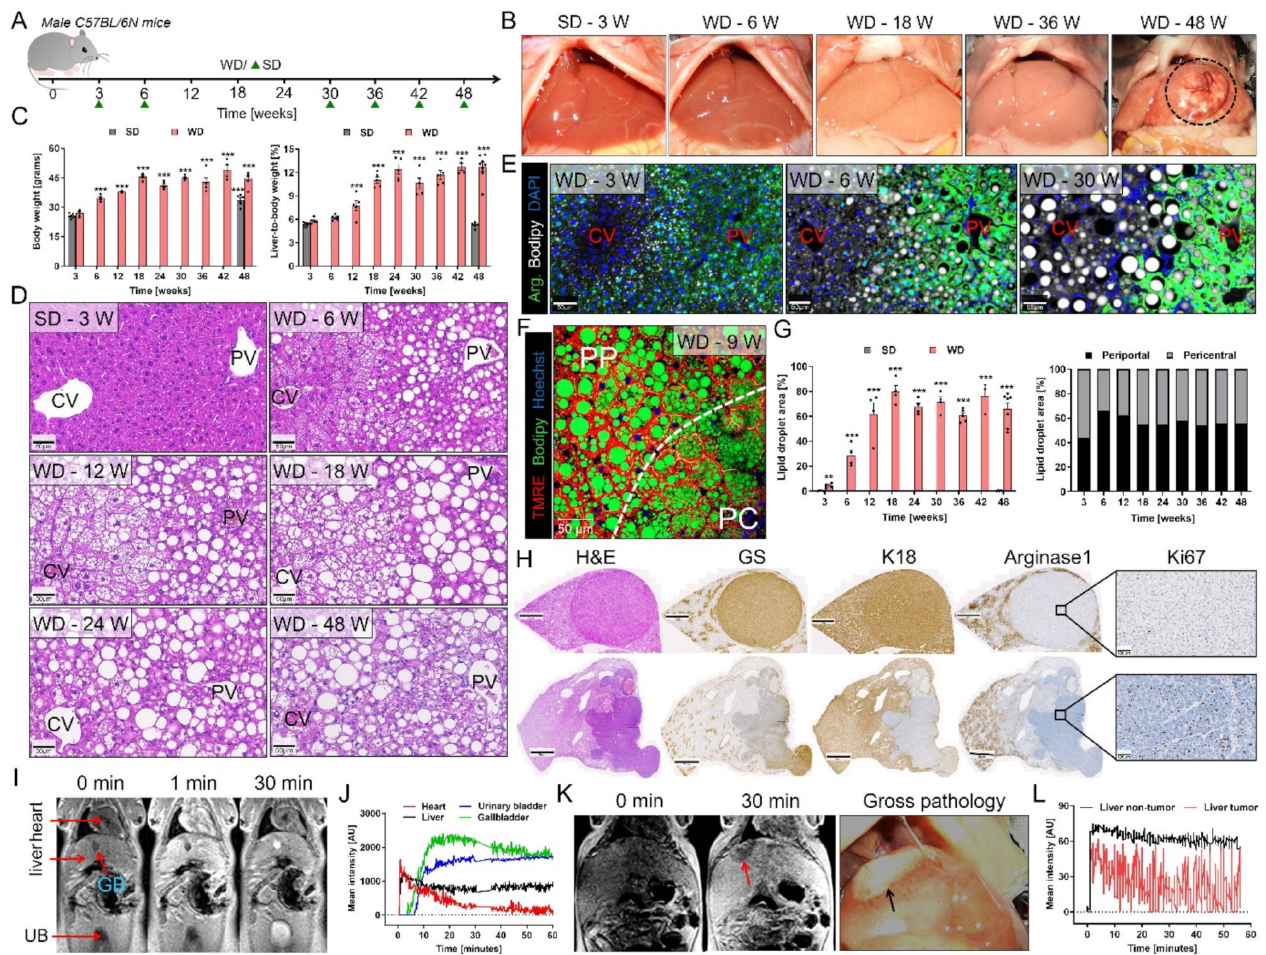
Figure 1. Lipid droplet accumulation and tumor development after Western diet feeding. ( A ) Experimental schedule indicating the number of weeks mice were on a SD or WD prior to analysis; green triangles: time periods with SD controls (details: Table 3). ( B ) Macroscopic appearance of the livers of mice on SD (week 3) and WD over 48 weeks. ( C ) Body weight and liver-to-body weight ratio. ( D ) Lipid droplet (LD) formation in H&E-stained liver tissue sections of mice fed a WD over 48 weeks; scale bars: 50 µ m. ( E ) Zonation of LD formation. LD appear white, the periportal/midzonal regions are green due to immunostaining for arginase1 (Arg.); blue represents nuclear staining by DAPI; CV: central vein; PV: portal vein; scale bars: 50 µ m. ( F ) Intravital visualization of LD using Bodipy (green). Differentiation of the periportal (PP) and pericentral (PC) lobular zones was achieved using the mitochondrial dye, TMRE, that leads to a stronger signal in the PP than the PC zone; scale bar: 50 µ m (see also Videos S1 and S2). ( G ) Quantification of LD in relation to lobular zonation. Data in C and G represent the mean and standard error of 4–7 mice per time point. **: p < 0.01; ***: p < 0.001 compared to SD week 3, Dunnett’s (C) or Sidak’s (G) multiple comparisons tests; data of individual mice are illustrated by dots; SD: standard diet; WD: Western diet. ( H ) Immunostaining of a GS positive (upper panel; scale bars: 1 mm for whole slide scans and 100 µ m for the closeup) and a GS negative (lower panel; scale bars: 2 mm for whole slide scans and 100 µ m for the closeup tumor nodule from 48-week WD-fed mice for the hepatocyte marker K18, the periportal/midzonal marker arginase1, and the proliferation marker Ki67. ( I ) Stills from MRI analysis of a SD-fed mouse, week 48, before (0 min), as well as 1 and 30 min after injection of the contrast agent gadoxetic acid; GB: gallbladder. ( J ) Quantification of the gadoxetic acid-associated signal in the regions of interest indicated in I. ( K ) Visualization of hepatocellular carcinoma (HCC) that appears as a hypodense region (red arrow) in the liver of a WD-fed mouse at week 48 in comparison to the gross pathology of the same mouse. ( L ) Mean intensity of the MRI signal of gadoxetic acid in the tumor and non-tumor region of the liver after injection of gadoxetic